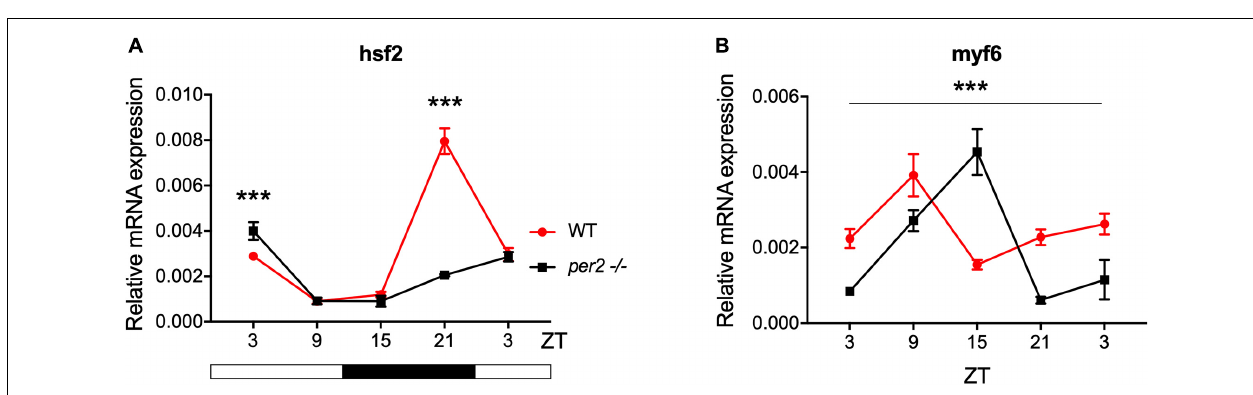
FIGURE 8 | Per2 knockout alters the rhythmic mRNA expression of CCGs in adult zebrafish skeletal muscle. qRT-PCR analysis of expression levels of the CCGs (A) hsf2 and (B) myf6 in WT and per2 KO skeletal muscle. Sets of 4 WT and per2 KO fish (each set containing two males and two females) were maintained under LD cycle (14 h light-10 h dark) conditions, muscle tissue was dissected and pooled for RNA extraction at 6-h intervals during a sampling window of 24 h. Mean mRNA relative expression ( n = 2–3) ± SD is plotted on the y -axis; zeitgeber time (ZT) is plotted on the x -axis. Zeitgeber times are indicated for each sample. ZT0 corresponds to lights-on, ZT14 to lights-off. A change in rhythm was observed for both CCGs, as determined by a significant ANOVA Genotype × Time interaction effect for all genes ( p < 0.001, see Table 1 ). myf6 exhibited a 6 h phase delay. Asterisks represent levels of significance in comparing the two genotypes at each time point individually, corrected by Sidak’s method (*** p <